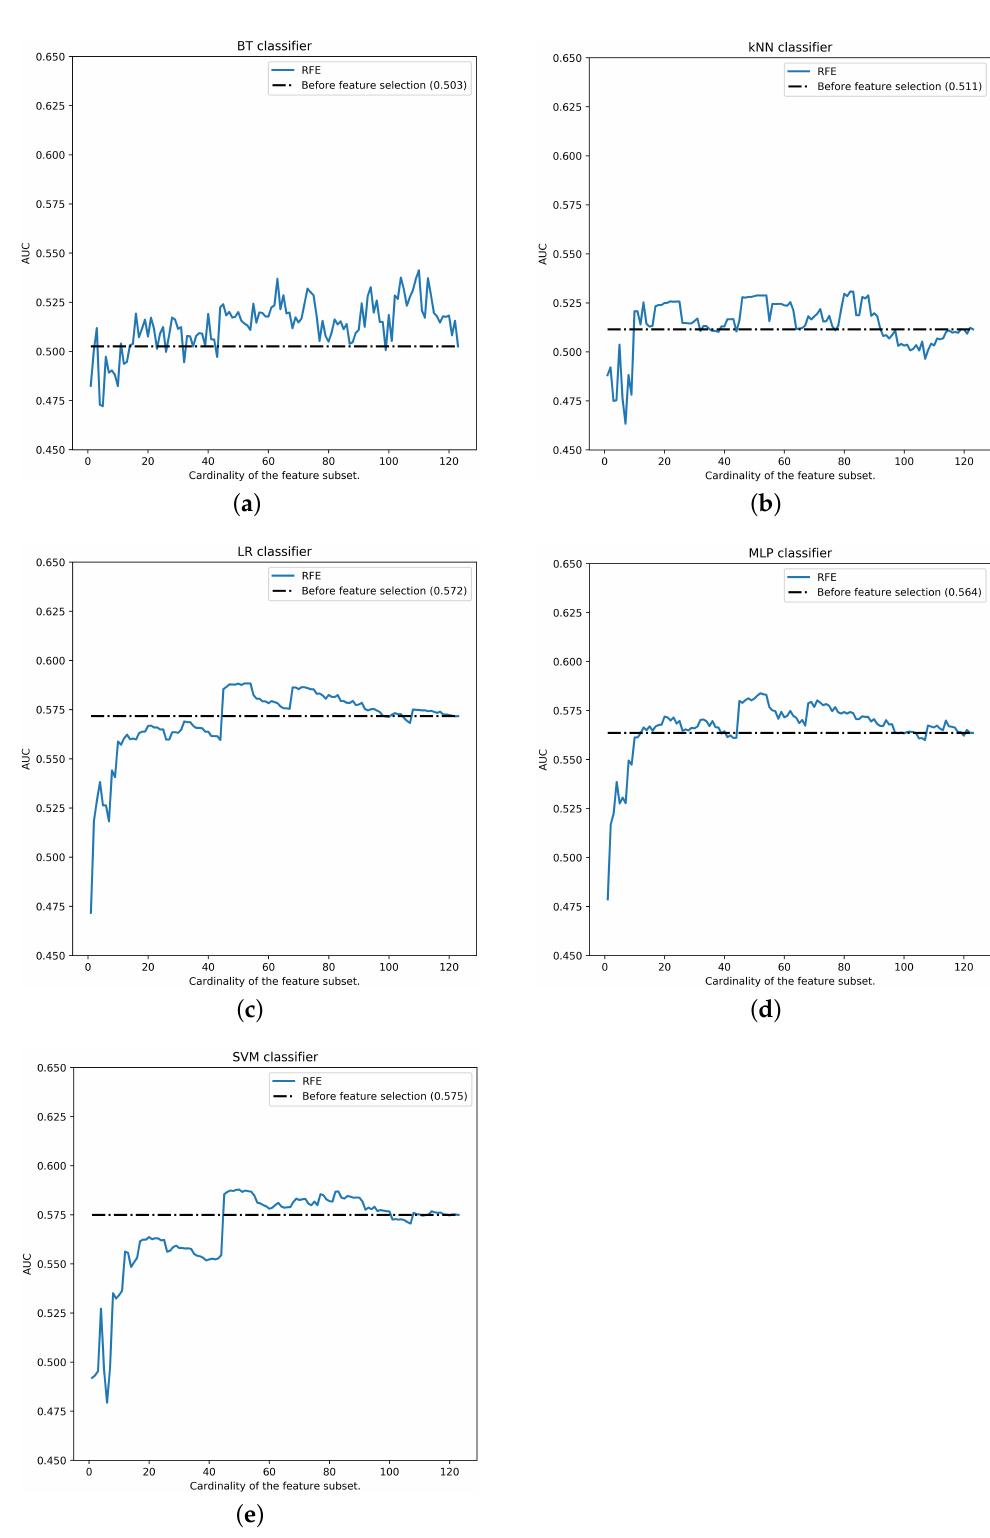
Figure 7. Performance for pre-menopausal data partition (by classifier): ( a ) BT, ( b ) k-NN, ( c ) LR, ( d ) MLP, ( e )